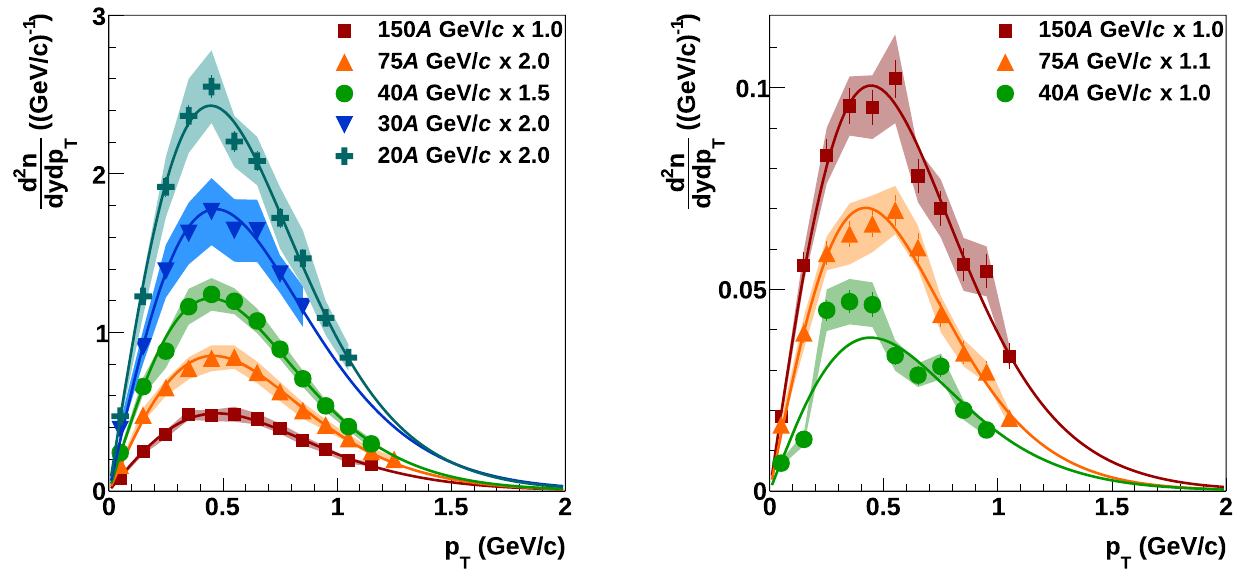
Fig. 27 Transverse momentum spectra of protons (left) and antiprotons (right) produced in 0 < y < 0 . 2 in the 20% most central Be+Be collisions. Colored lines represent the fitted function (Eq.